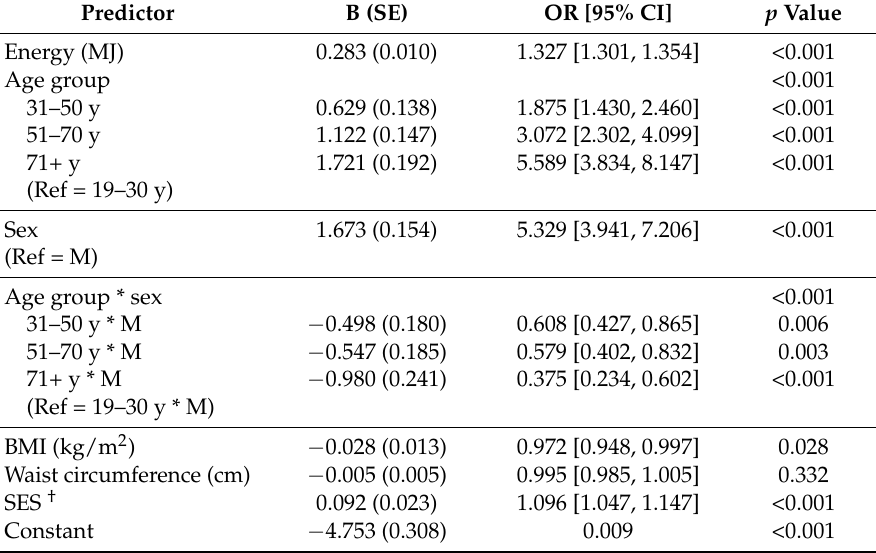
Table 5. Binary logistic regression analysis of predictors of meeting fibre SDT * among adults aged 19 years and